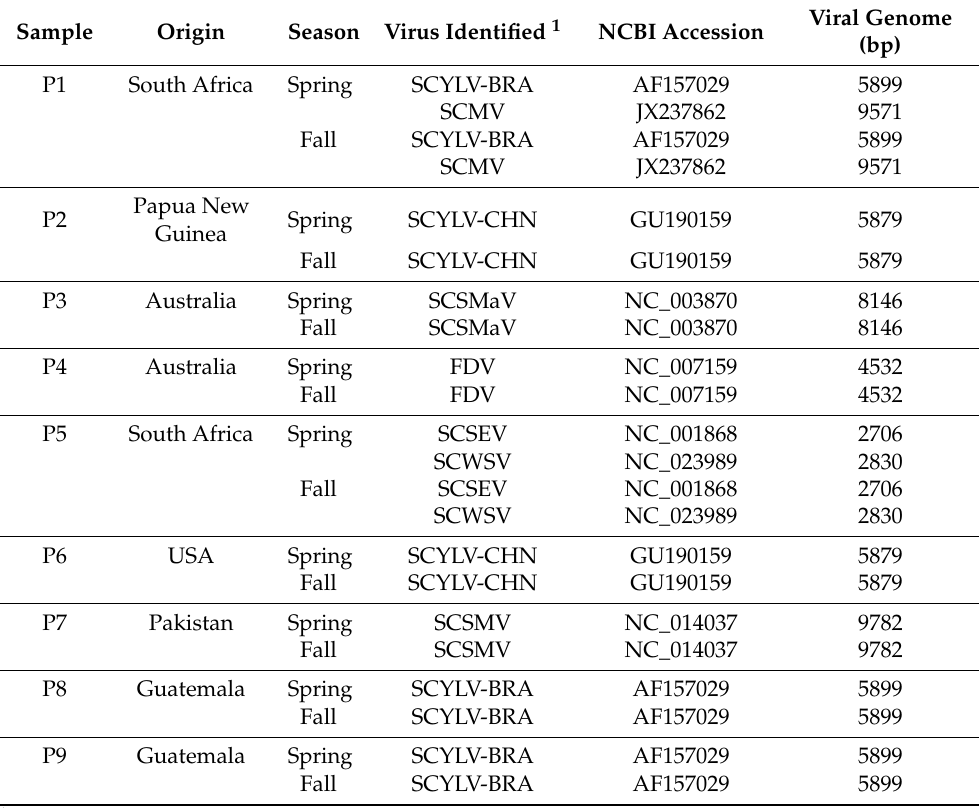
1 Abbreviations: sugarcane yellow leaf virus-Brazil (SCYLV-BRA); sugarcane mosaic virus (SCMV); sugarcane yellow leaf virus-China (SCYLV-CHN); sugarcane striate mosaic associated virus (SCSMaV); fiji disease virus (FDV); sugarcane streak Egypt virus (SCSEV); sugarcane white streak virus (SCWSV); sugarcane streak mosaic virus